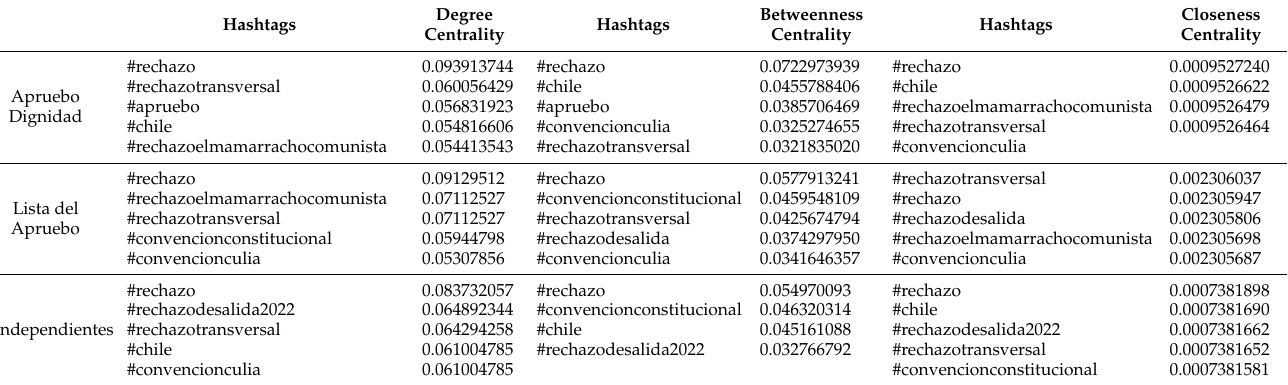
Table 8. Five highest hashtags in local network metrics with hate speech